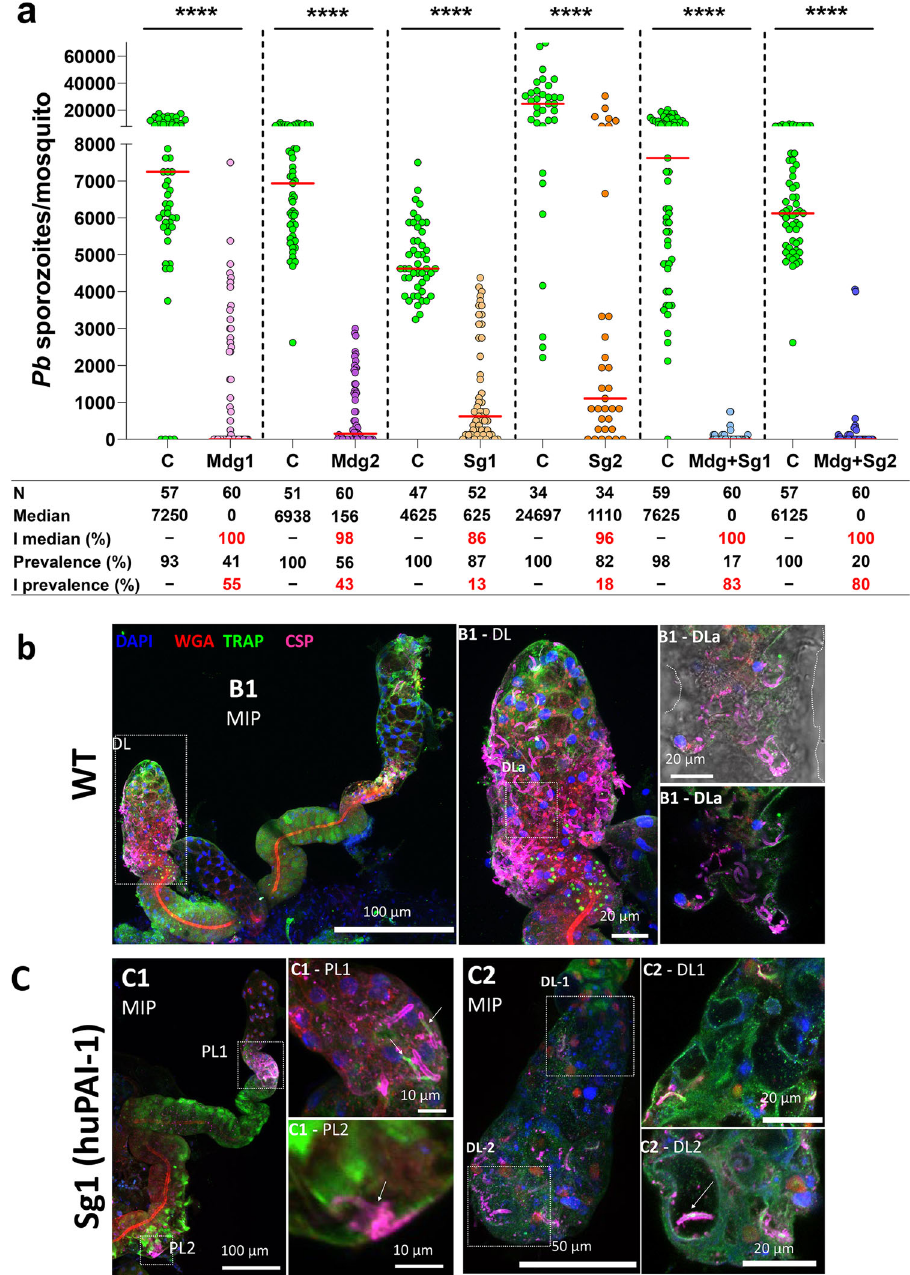
Fig. 6 Salivary gland infection is inhibited in transgenic mosquitoes. a huPAI-1 reduces sporozoite numbers in the salivary glands of transgenic mosquitoes. Control and transgenic mosquitoes were simultaneously fed on the same P. berghei infected mouse and salivary gland sporozoite numbers were determined 21 days post-feeding. Control experiments were done with either WT mosquitoes or the parental lines MdgD1, QUAS1, QUAS2, SgD1 (Supplementary Data 1, Dataset 7). Horizontal red lines represent the median sporozoite number of data pooled from three independent experiments shown in Supplementary Data 1. Control groups were done with either WT mosquitoes or the parental lines SgD1, MdgD1, QUAS1 or QUAS2 (Supplementary Fig. 5 and Supplementary Data 1, Dataset 7). Statistical analysis was done by two-tailed Mann – Whitney U test, **** P < 0.0001. C control, I inhibition, N number of analyzed mosquitoes. The percent inhibition of median and prevalence was calculated as follows: 100 × [(number of sporozoites in the control − number of sporozoites in the experimental)/(number of sporozoites in the control)]. b , c Salivary glands expressing huPAI-1 are poorly invaded by sporozoites. Salivary glands dissected 21 days post infection were stained with anti-TRAP (parasite; green) and anti-CSP (parasite; magenta) antisera, DAPI (DNA, blue), and WGA (chitin/O-GlcNAcylation; red). Representative WT and Sg1 ( c ) salivary gland 3D projection (MIP) or single slice confocal images are shown. b WT salivary glands show robust invasion, including sporozoite occupancy of secretory cavities and lumens. c Salivary glands of mosquitoes overexpressing huPAI-1 show sparse invasion frequently mistargeted to the PL lobes (c1-PL1) and dead parasites associated with the basement membrane (c1-PL2, arrow). Interestingly, loss of most sporozoite CSP staining is observed upon invasion (c1-PL1, arrows). Rare DL lobes (4/33) that possessed secretory cavities and/or a lumen showed sporozoite invasion of these regions (arrow in c2-DL2). Data presented in panels b-c are representative of at least two independent experiments. Additional examples of infected salivary glands from the Sg1 line are shown in Supplementary Fig.